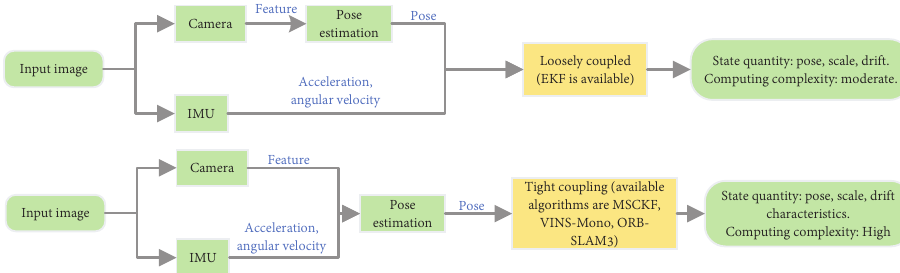
Figure 15. Frames of loose coupling and tight coupling of visual inertial